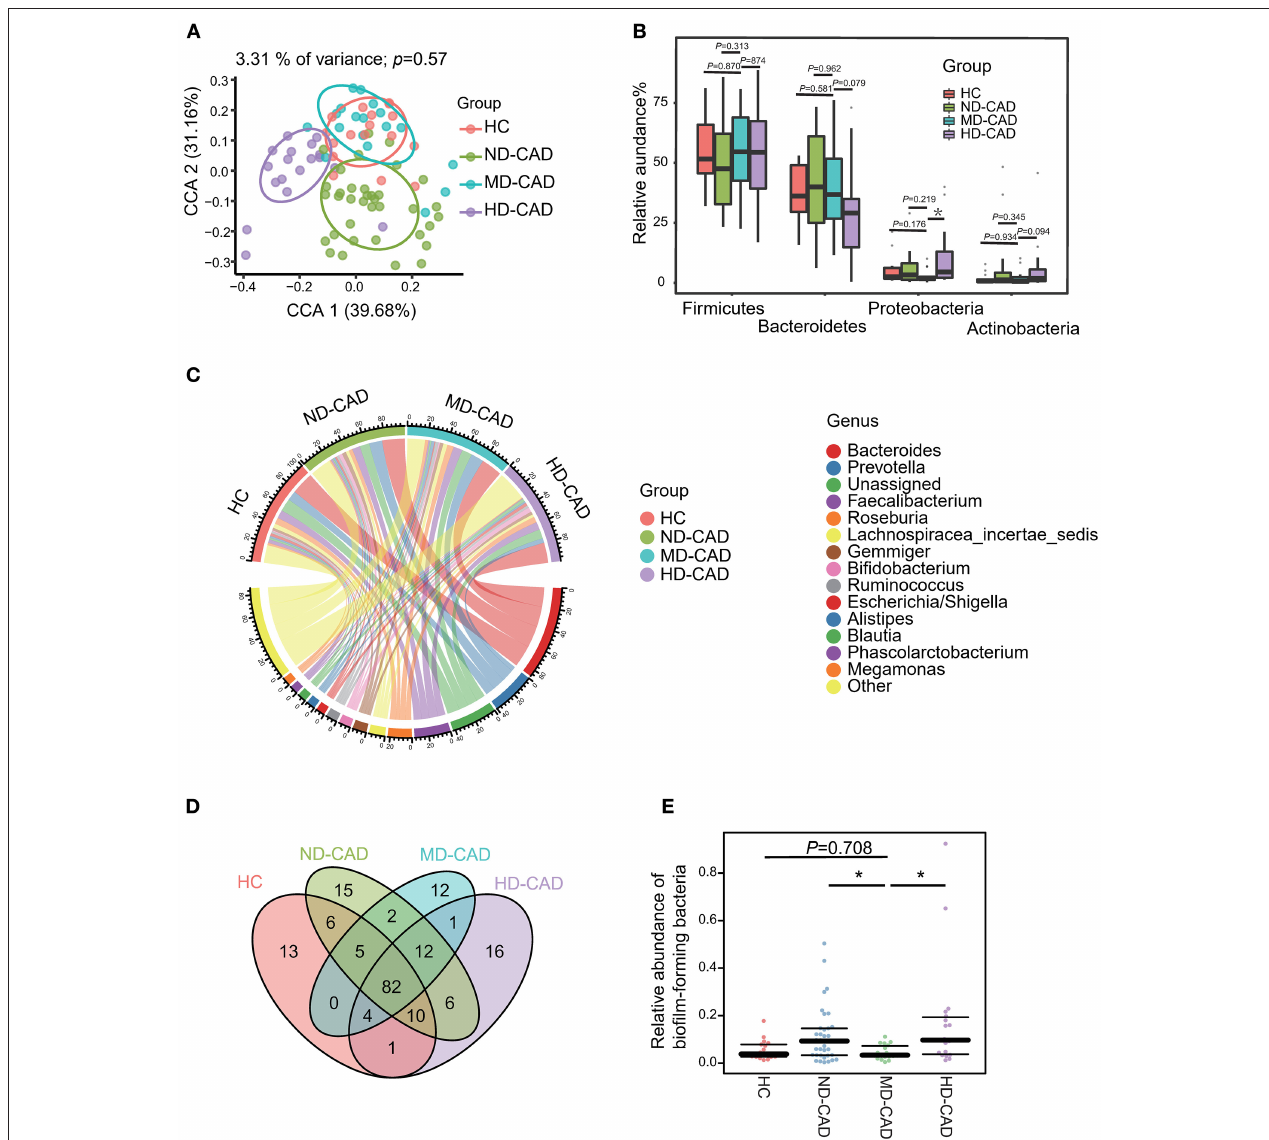
FIGURE 3 | Different alcohol consumption affects the taxonomic features of gut microbiota in patients with CAD. (A) Beta diversity analyzed by CPCoA plot based on Bray-Curtis distances ( P = 0.57, Adonis Test). (B) Comparison of the relative abundance of gut microbiota at the phylum level (ns, not significant, * P < 0.05, Mann—Whitney U -test. Phylum Proteobacteria: MD-CAD vs. HC: P = 0.176, MD-CAD vs. ND-CAD: P = 0.219, MD-CAD vs. HD-CAD: P = 0.019). (C) Chord plot showing the dominant genera and their contribution to each group. (D) Venn plot indicating the number of overlapped OTUs. (E) Relative abundance